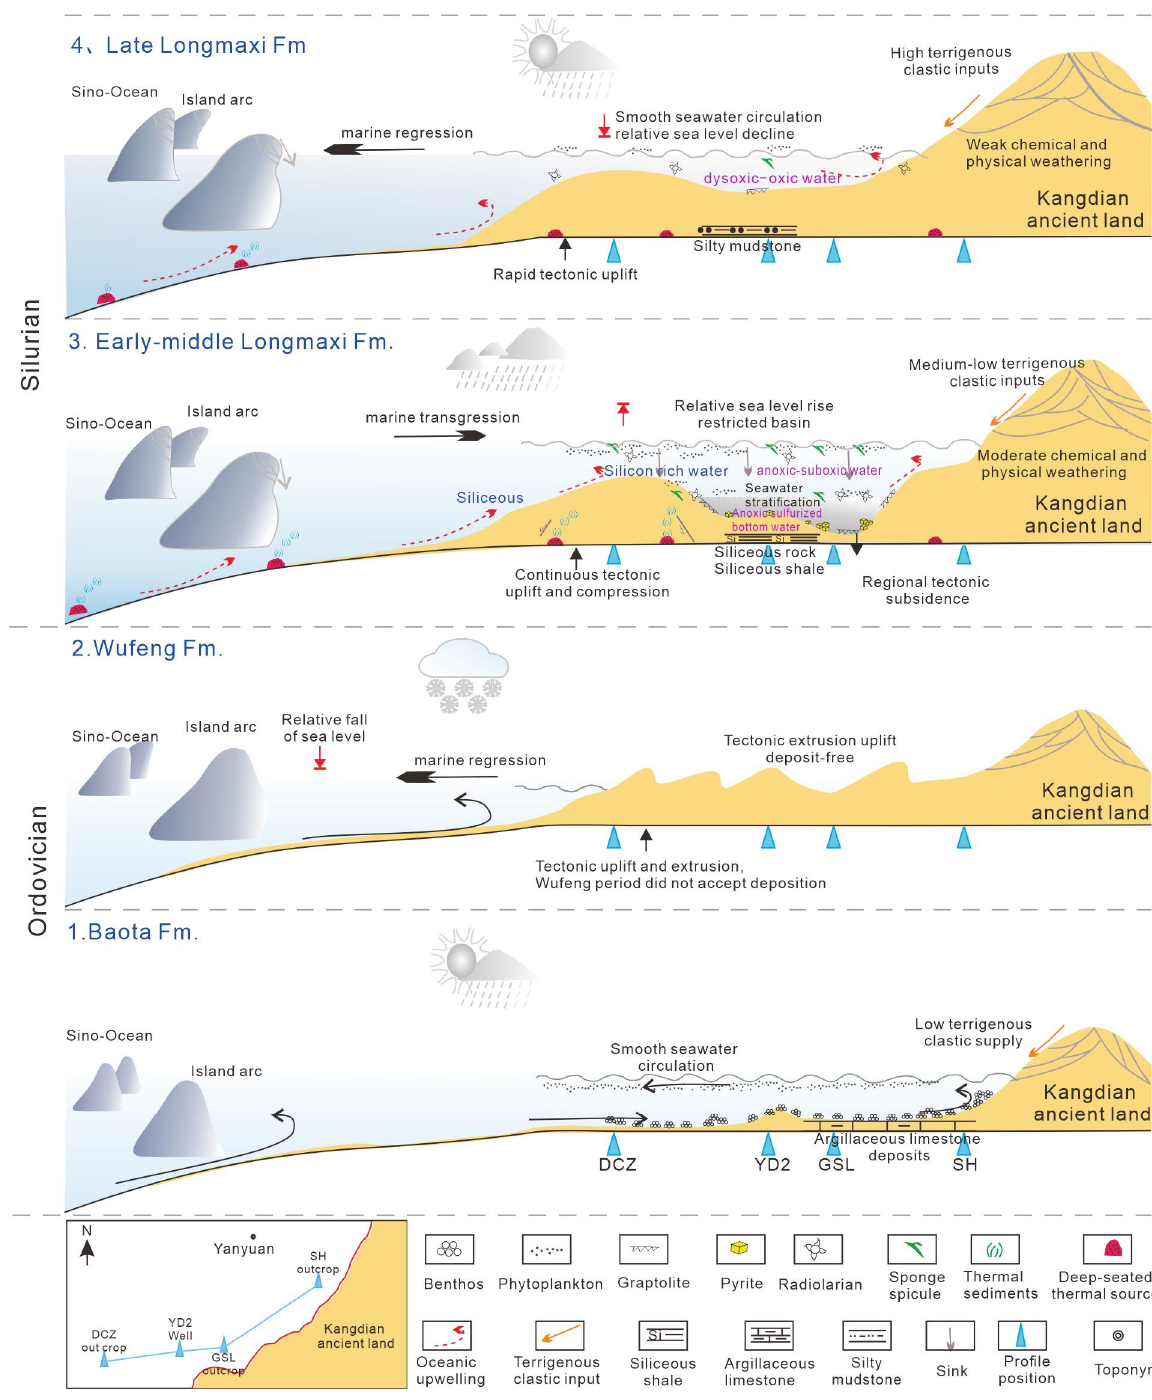
Figure 9. Sedimentary tectonic evolution model of the Yanyuan Basin. ( 1 ) The Ordovician Baota period: a shallow sea carbonate platform developed and experienced progressive uplift. ( 2 ) The Ordovician Wufeng period: the study area was uplifted and denuded, and no sediment was found. ( 3 ) Early stage of the Silurian Longmaxi period: glacial period ended and the global sea level rose, and regional tectonic subsidence formed a restricted basin, under the cold climate of the late Ordovician, with weak chemical weathering and less input of terrigenous detritus. ( 4 ) Late stage of the Silurian Longmaxi period: sudden tectonic uplift results in relative sea level falling and the climate was gradually warming and chemical weathering increased and influenced the increment of terrigenous detrital.